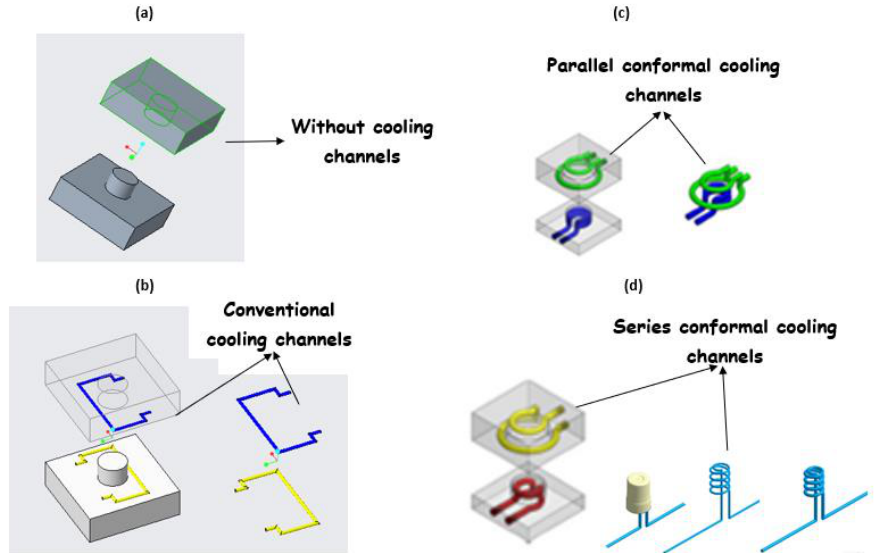
Figure 4. ( a ) Pressure field and temperatures in a refrigeration system. ( b ) Cooling system by means of baffles.